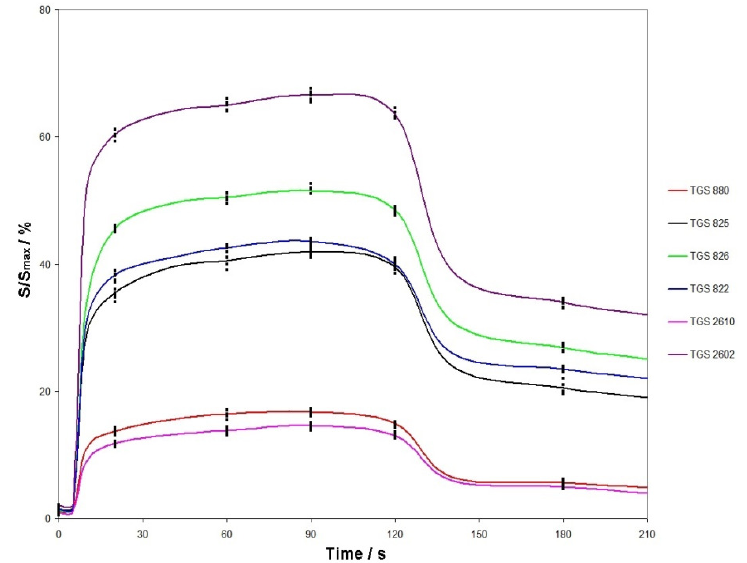
Figure 2. TGS sensors response signal versus time. Volumetric flow rate of